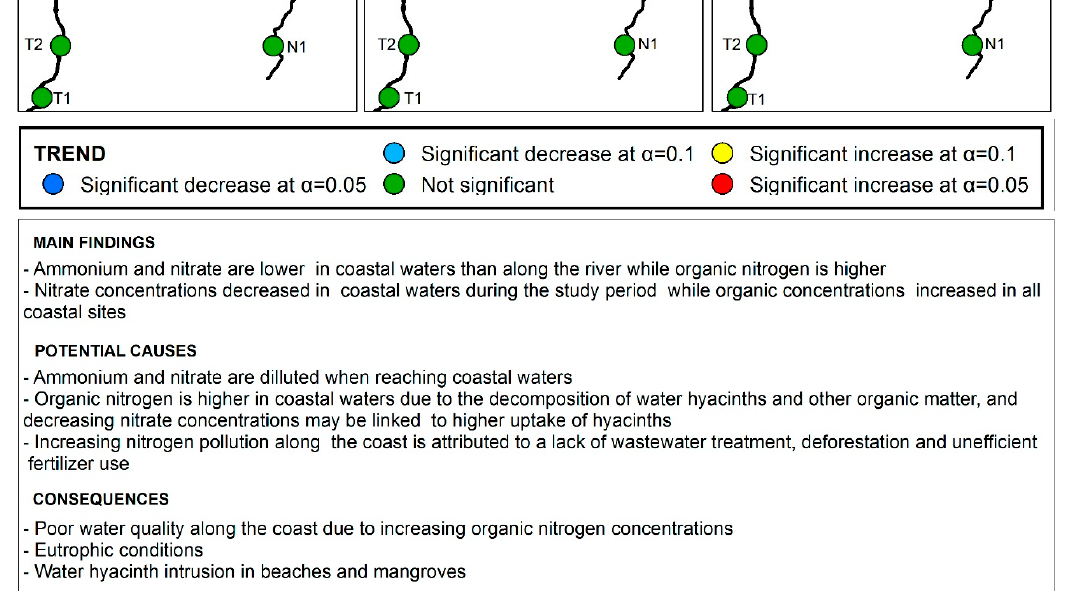
Figure 7. Summary of main findings and potential causes and consequences of nitrogen pollution. Nitrogen concentrations were calculated as the median of four annual measurements from 2013 to